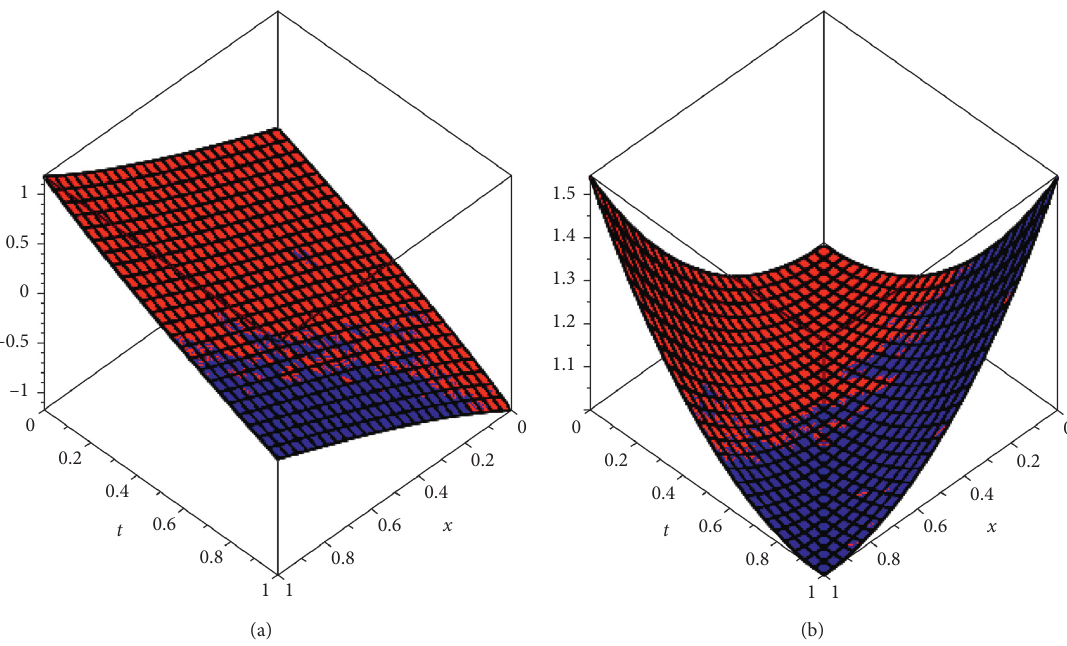
Figure 8: Comparison of the exact solution (blue) and the approximate solutions (red) of Example 8 for α � 1. (a) The solution of w (b) The solution of v n ( x, t ) .